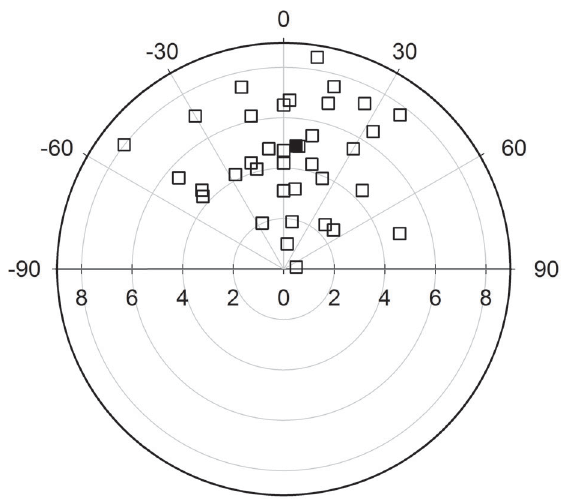
Figure 1. Performances of control conditions. Plots of all strikes (unfilled squares) for snakes in the control condition indicating strike distances (cm) and angles ( u ). The filled square represents the mean strike distance and angle in the control condition.